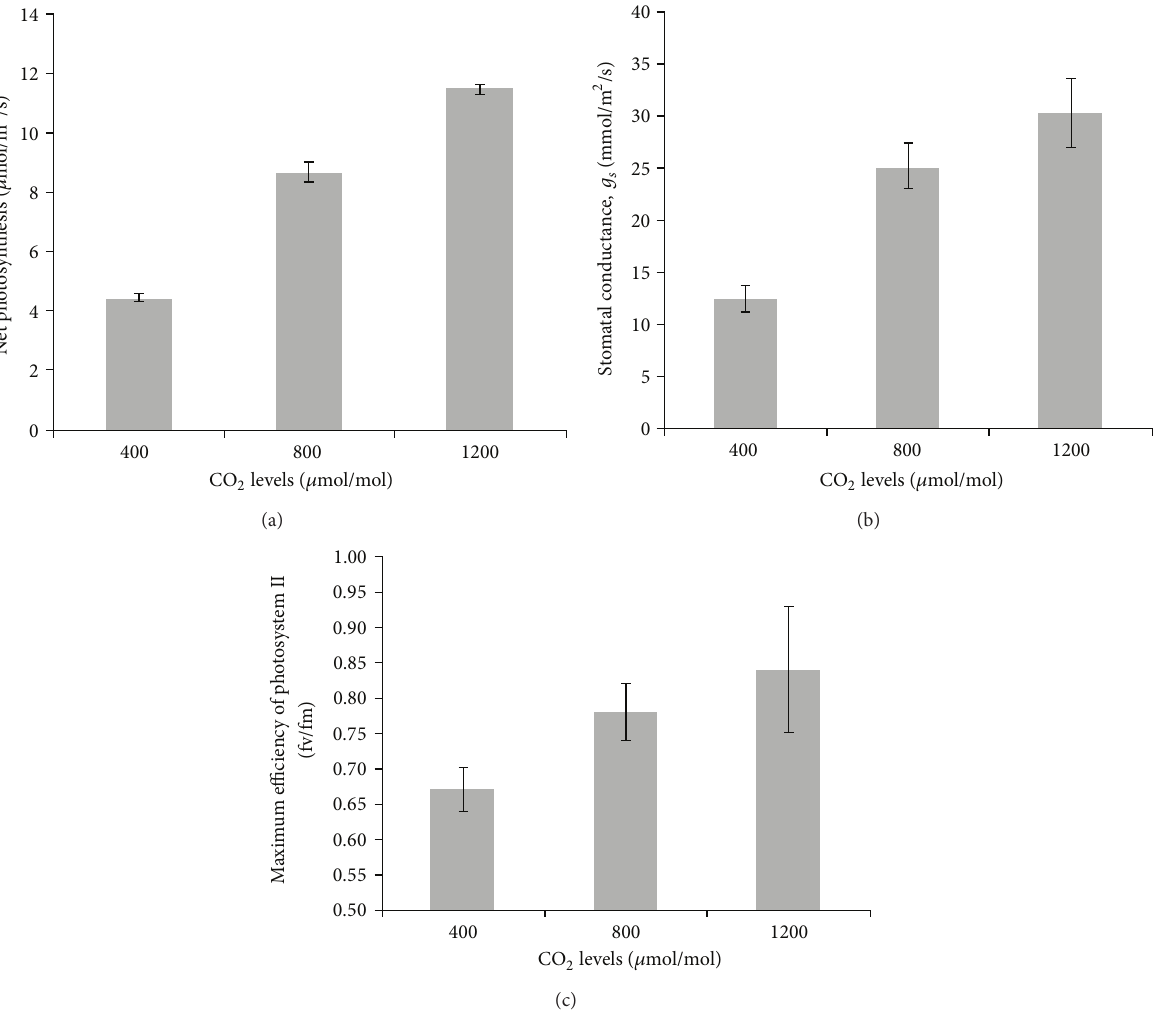
Figure 3: Impact of elevated CO 2 on (a) net photosynthesis, (b) stomatal conductance, and (c) maximum efficiency of photosystem II ( 𝑓 V / 𝑓 𝑚 ) in Labisia pumila ; 𝑁 = 84 . Bars represent standard errors of differences between means (SEM).